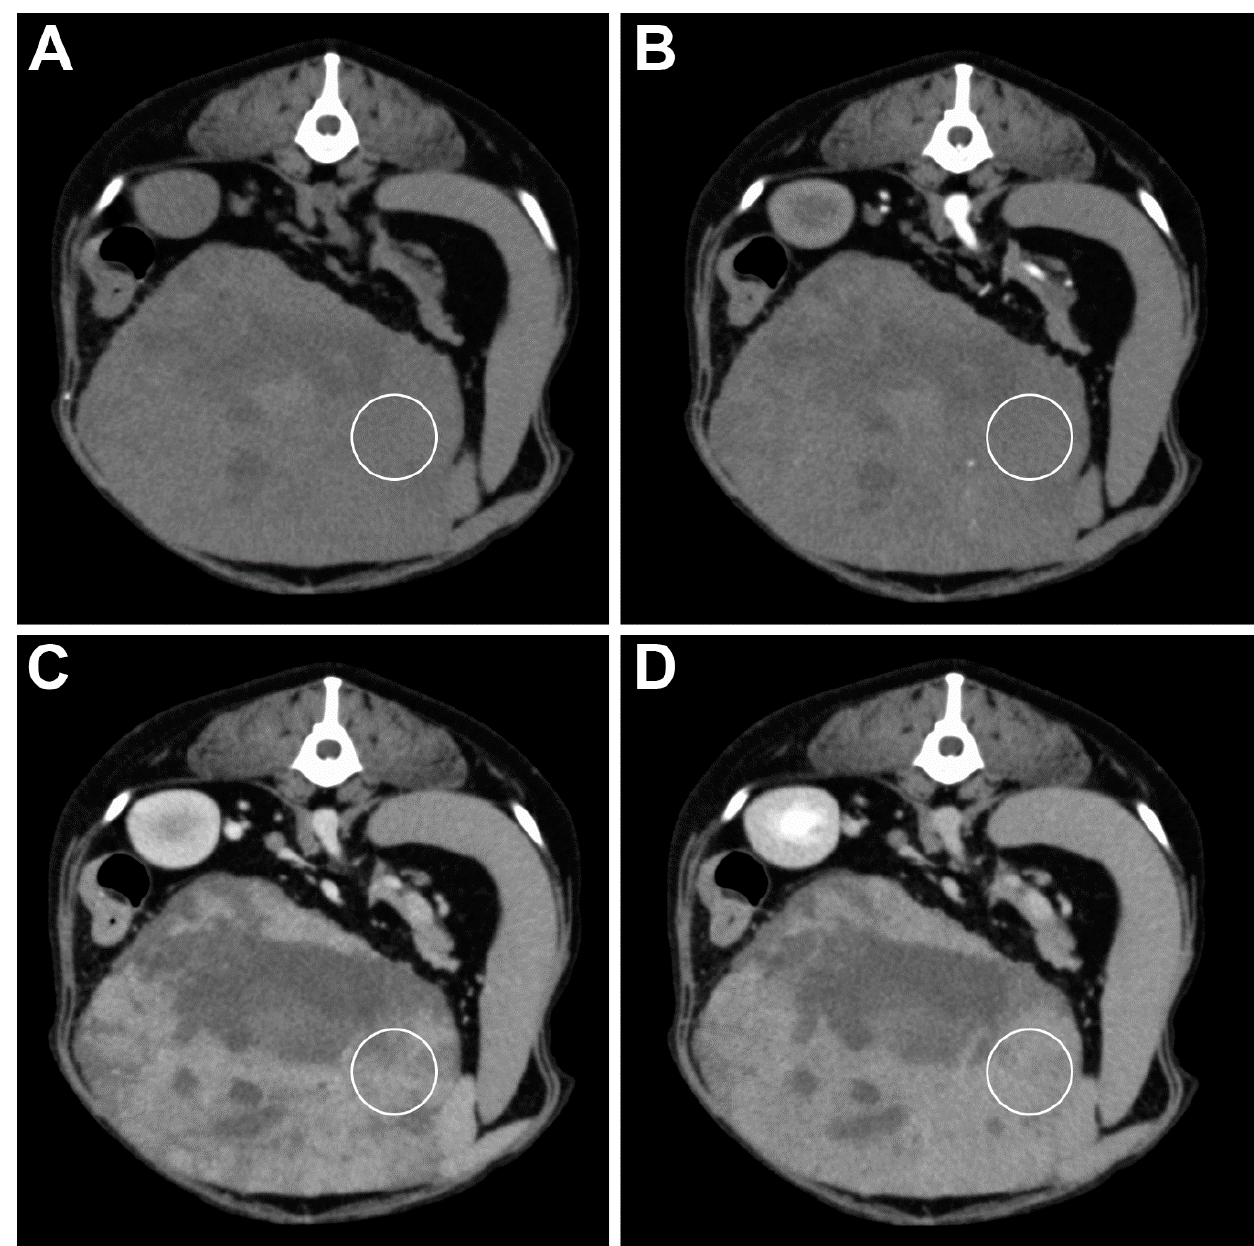
Figure 3. Transverse plane images of a TP-MDCT in a dog with a hepatic adenoma. ( A ) The pre-contrast image shows a large isoattenuating mass with multiple hypoattenuating areas. ( B ) In the arterial phase, the mass is of the same attenuation, and only a few tiny vessels are visible within the mass. The heterogenous contrast enhancement of the mass in the portal ( C ) and delayed ( D ) phase and the large hypoattenuating central area is present. The white circle shows the location of the ROI used for the measurement.